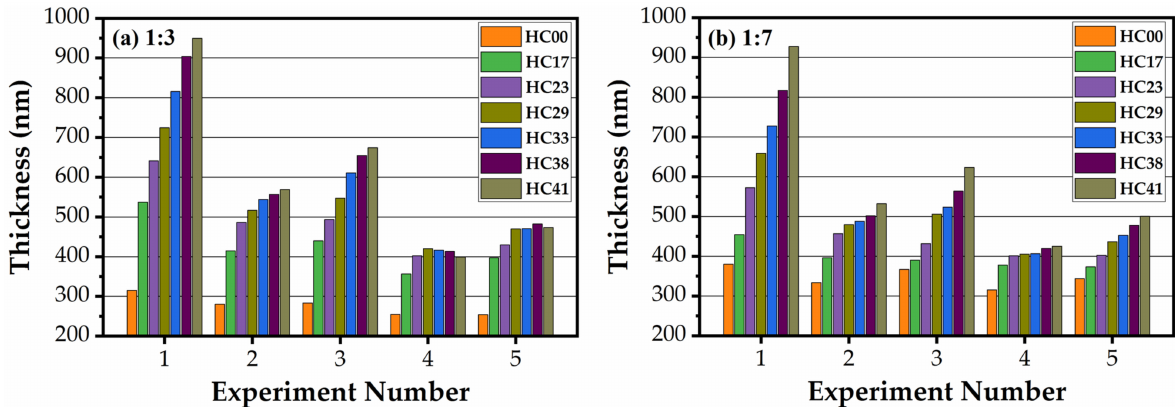
Figure 2. Dependence of film thickness on the template (0 to 41 wt%, numbered from HC00 to HC41) and benzene-bridge content for ( a ) 1:3, and ( b ) 1:7 materials. The experiment number corresponds to (1) as-deposited (AD), (2) after soft baked in air for 30 min (SB-Air), (3) soft baked in N 2 for 30 min (SB-N 2 ), (4) hard baked in air for 30 min (HB-Air), and (5) hard baked in N 2 for 60 min (HB-N 2